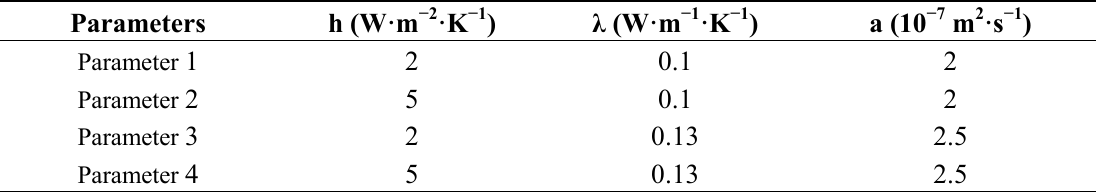
Table 3. Parameters used for the sensitivity analysis.